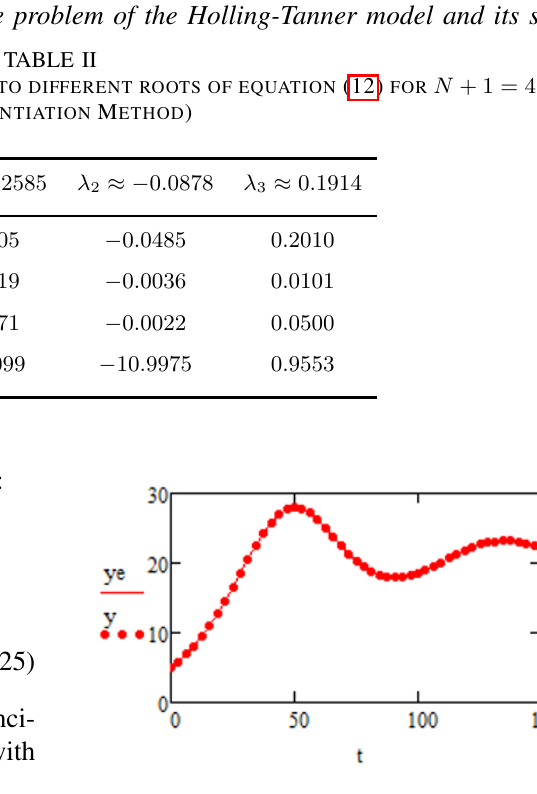
Fig. 6. Graph of original solution y = y ( t ) (dots) and solution with estimated parameters (solid line)